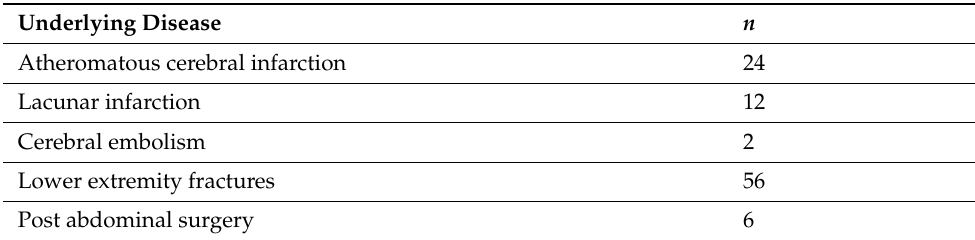
Table 2. The underlying disease of the study